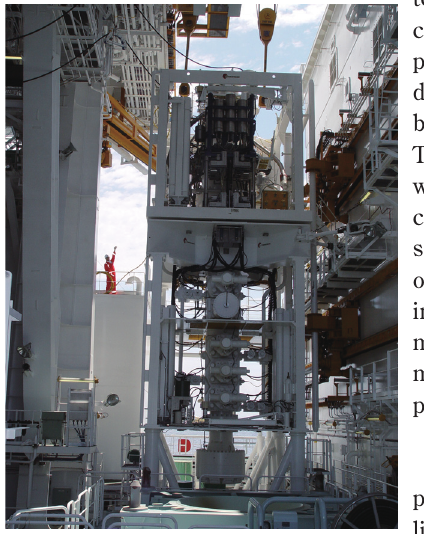
Photos courtesy of Japan Agency of Marine-Earth Science and Technology (JAMSTEC) Related Web Link